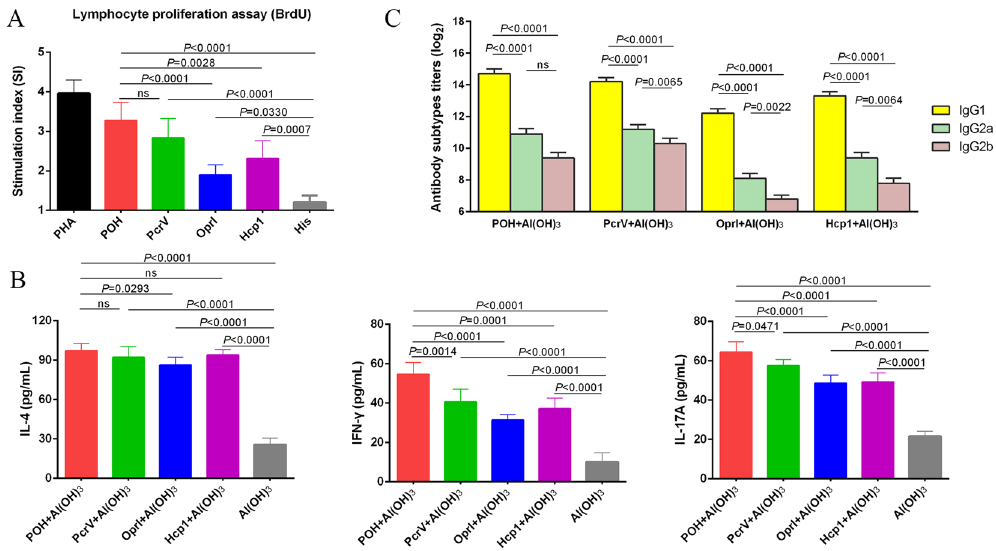
Figure 5. Analysis of splenocyte proliferation, cytokines and antibody responses. ( A ) Lympho-proliferative activity of mouse splenocytes (n = 5) after in vitro stimulation with POH, PcrV, OprI, or Hcp1 for 72 h, respectively. Proliferation was measured using the bromodeoxyuridine (BrdU) labeling method. ( B ) Comparison of cytokine production by antigens stimulated splenocytes from immunized and control mice. Two weeks after the final immunization, spleens (n = 5) were processed and stimulated with POH, PcrV, OprI, or Hcp1, and the levels of IL-4, IFN- γ , and IL-17 in each culture supernatant were measured after 72 h. ( C ) Comparison of serum IgG1, IgG2a and IgG2b subtypes among antigens in the immunized mice (n = 5). Serum was obtained at two weeks after the final immunization, and the levels of IgG1, IgG2a and IgG2b subtypes were expressed as the mean of log 2 titers. Multiple comparisons among different groups were analyzed using one-way ANOVA (ns = no significance). Data were shown as the mean ±